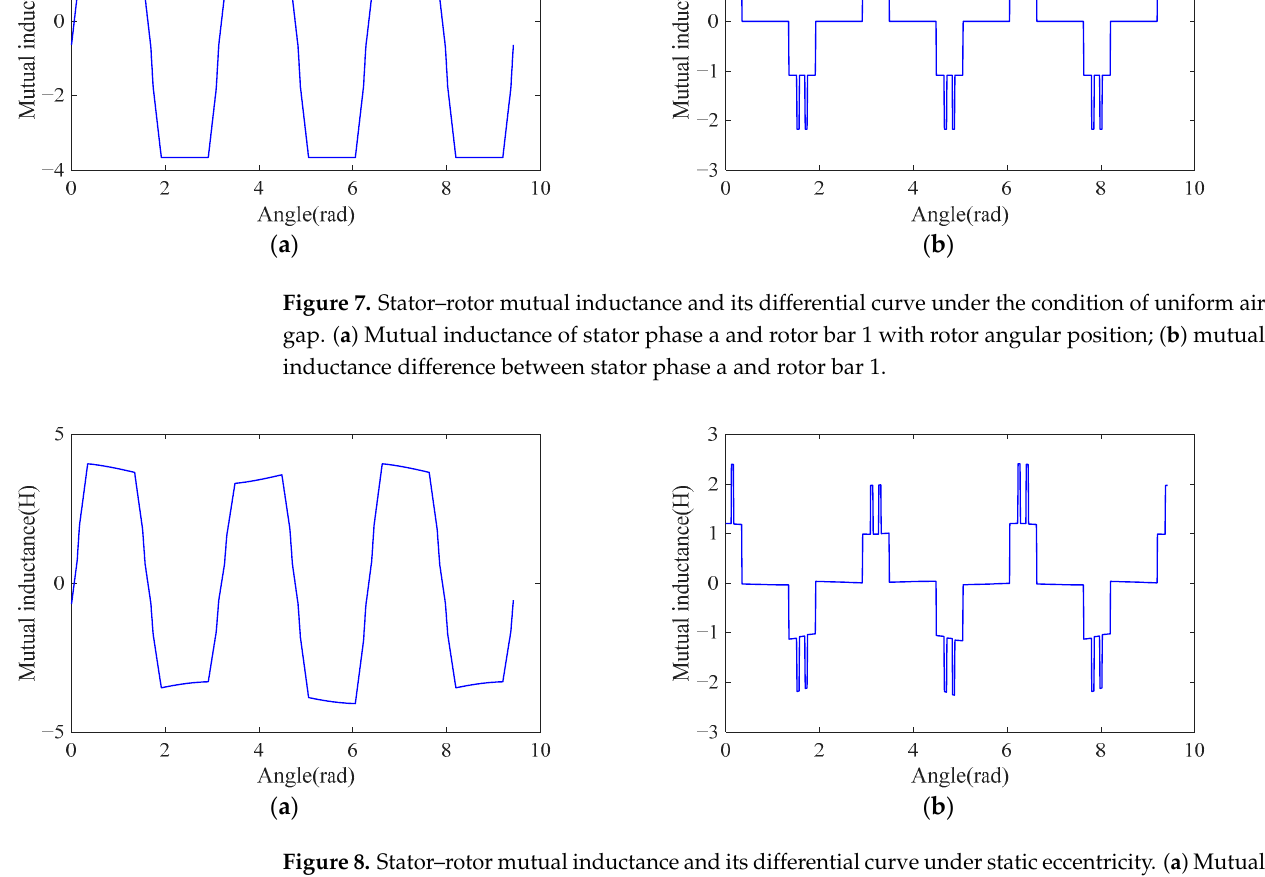
Figure 8. Stator–rotor mutual inductance and its differential curve under static eccentricity. ( a ) Mutual inductance of stator phase a and rotor bar 1 with rotor angular position; ( b ) mutual inductance difference between stator phase a and rotor bar 1.